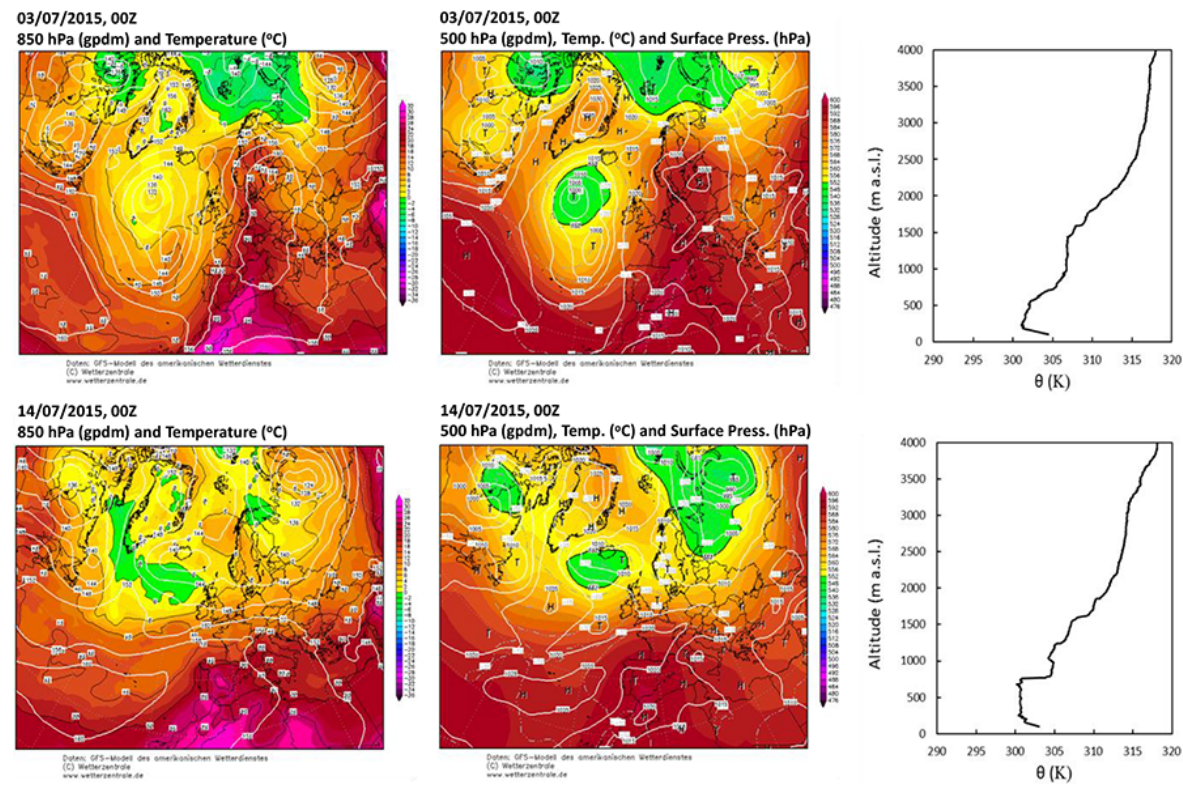
Figure 2. Geopotential and temperature at 850hPa (left) and 500hPa (centre). Potential temperature (K) of the atmospheric sounding in Barcelona (WMO 08190) at 12:00UTC (right). Meteorological figures are reported for 3 July 2015 (top) and 14 July 2015